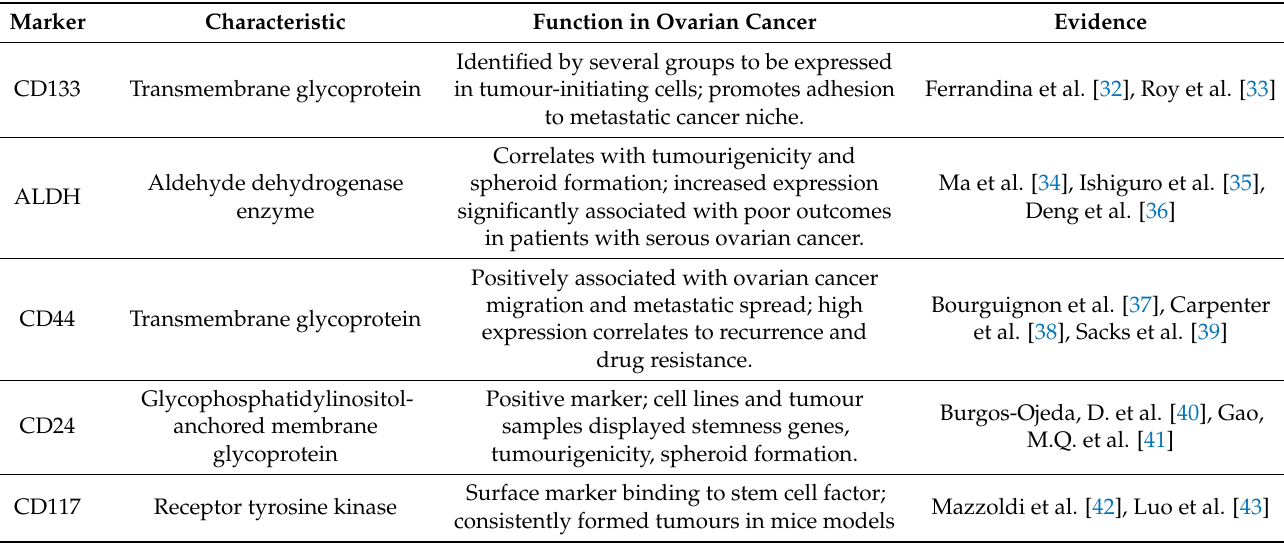
Table 1. Markers associated with